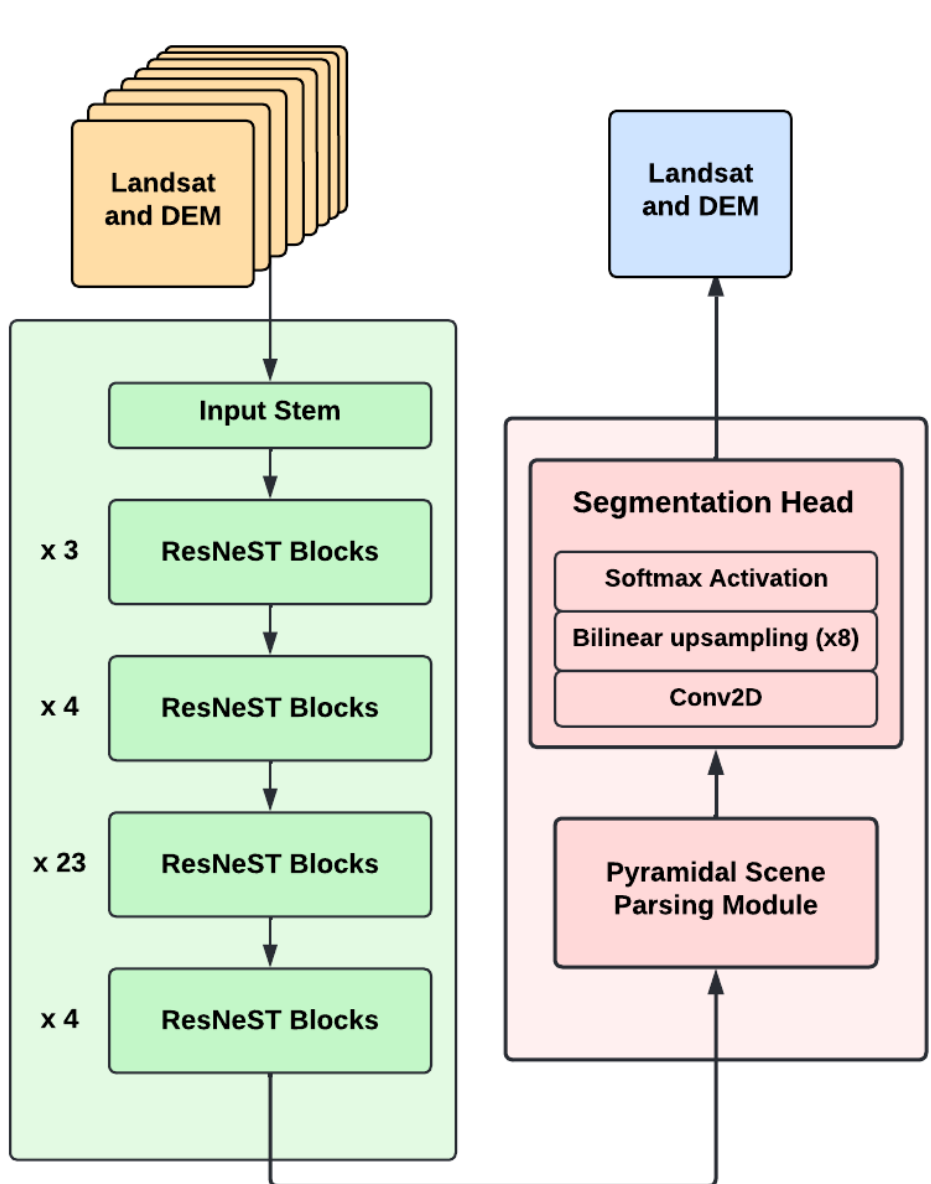
Figure A1. Conceptual diagram of GlacierCoverNet model architecture and processing scheme.